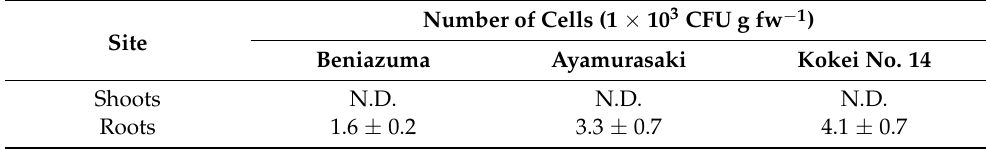
Table 1. Population density of Bradyrhizobium AT1-SR in the three cultivars of sweet potato 2 weeks after inoculation.